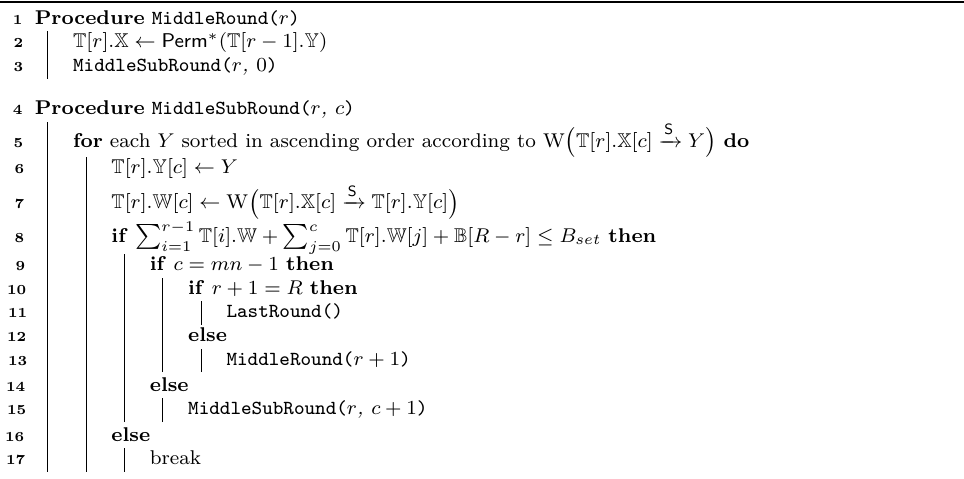
Algorithm 3: The sub-procedure version of MiddleRound() in Algorithm 1